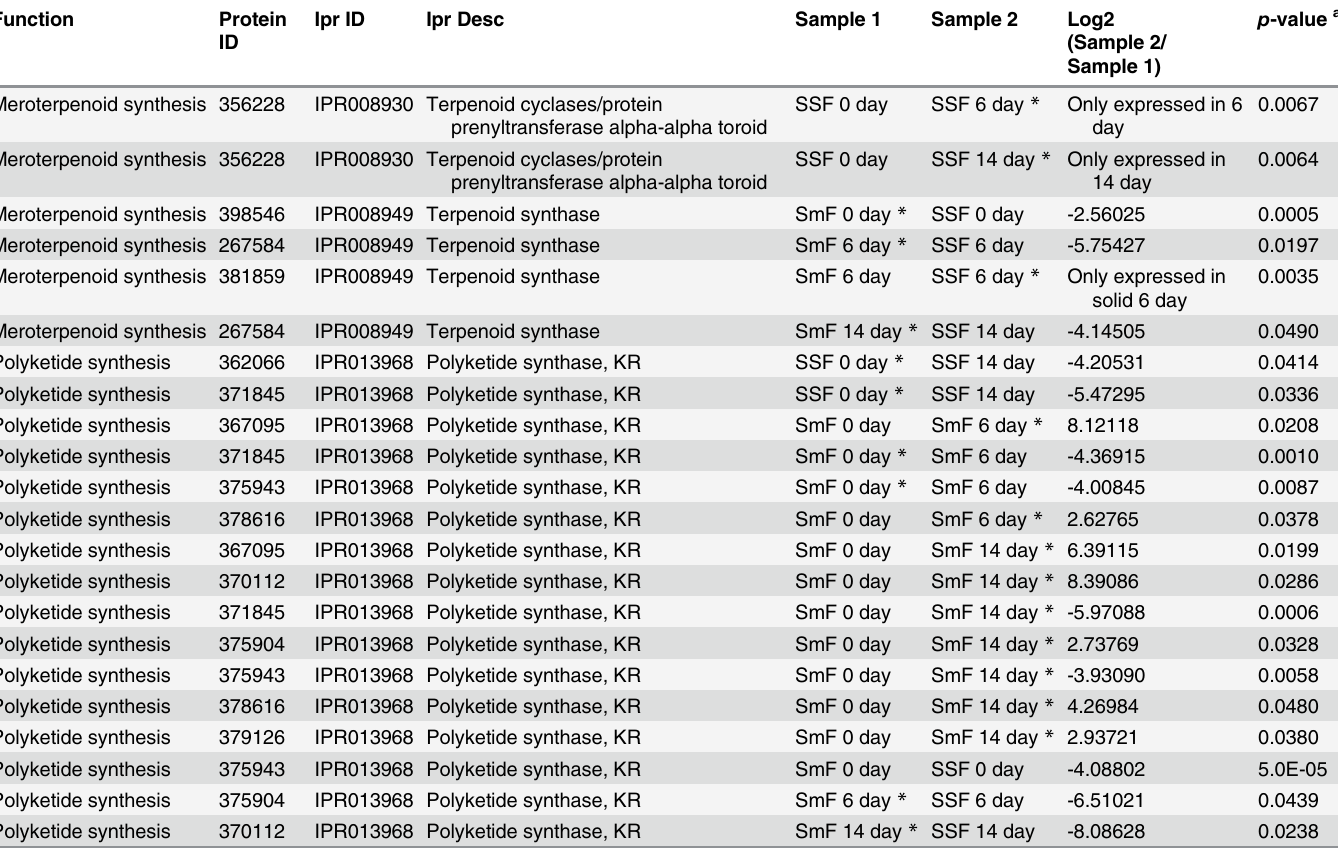
Table 2. Transcripts related with polyketide and meroterpenoid compounds synthesis in the different fermentation states and time.